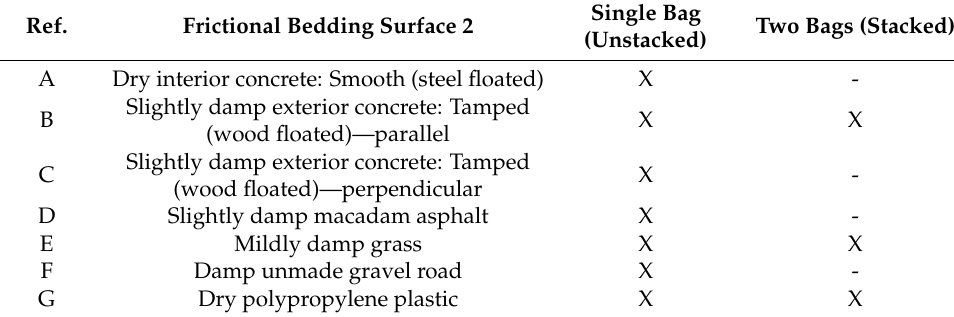
Table 3. Field testing